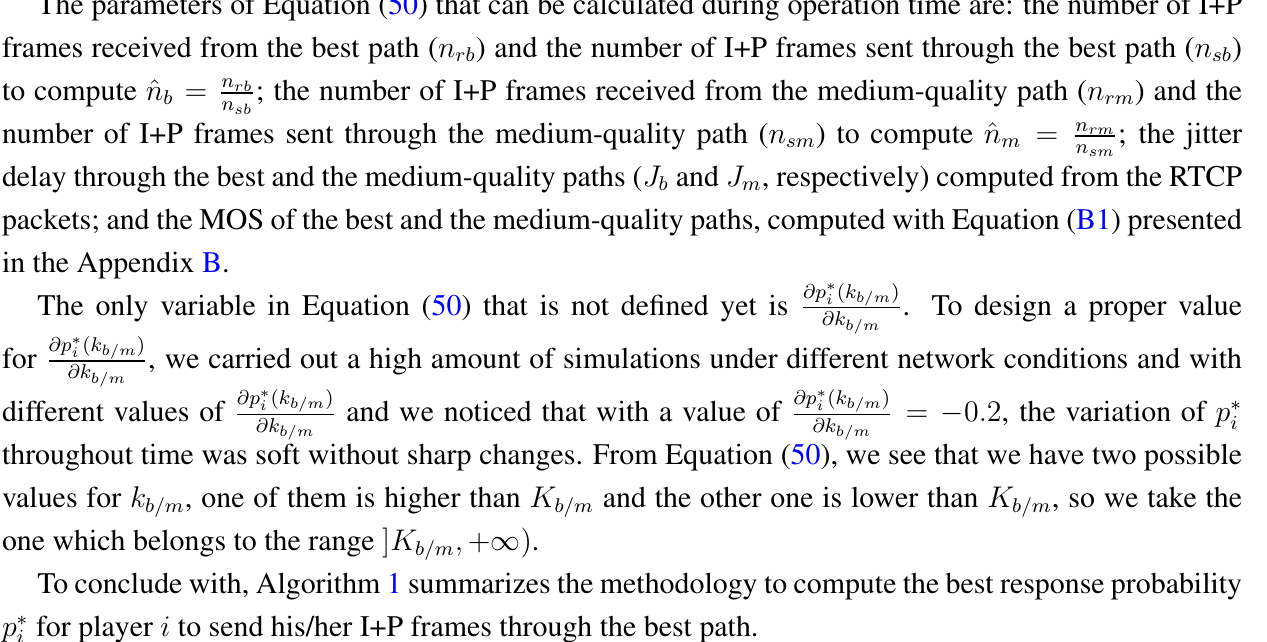
as a function of k i